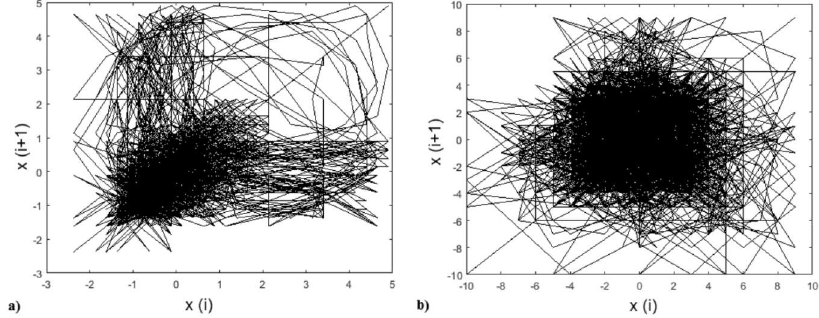
Figure 6. Phase space reconstruction for the EHG